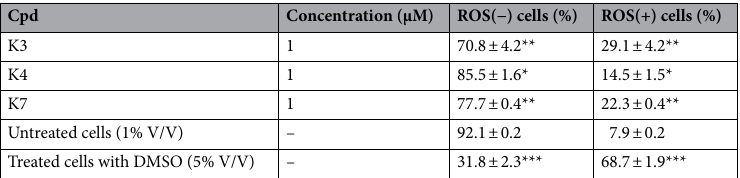
Table 5. Induction of the oxidation stress by selected selenoesters in human sensitive ovarian adenocarcinoma cell line (HOC). Data are expressed as the average of the cell percentage number of three repetitions with standard error of the mean (SEM). The statistical differences between two datasets were calculated by using a two-compound t-test at the level *p < 0.05, **p < 0.01, ***p < 0.001.